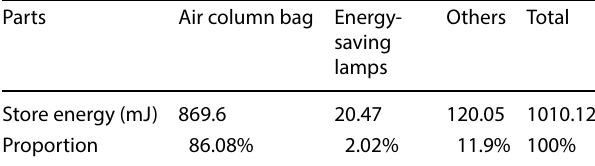
Table 4 Initial inflation pressure: 40 kPa